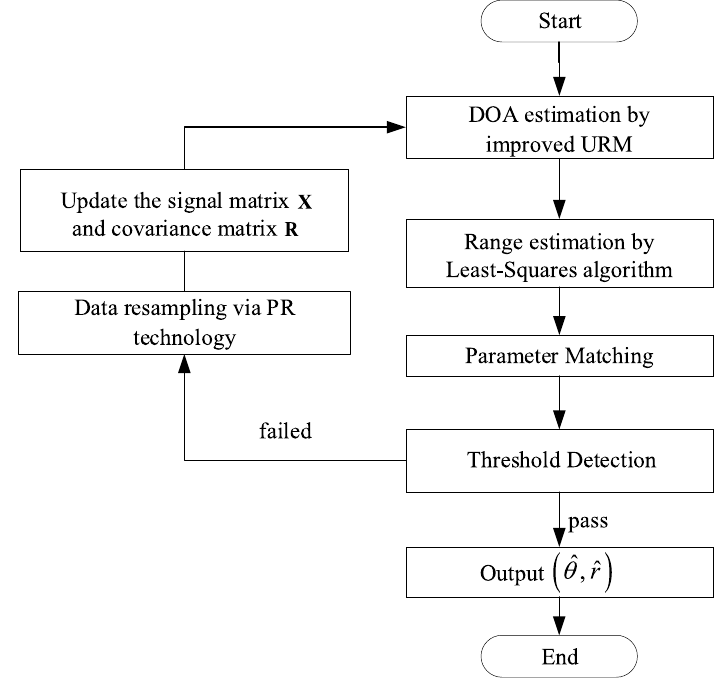
Figure 4. Structure of the proposed